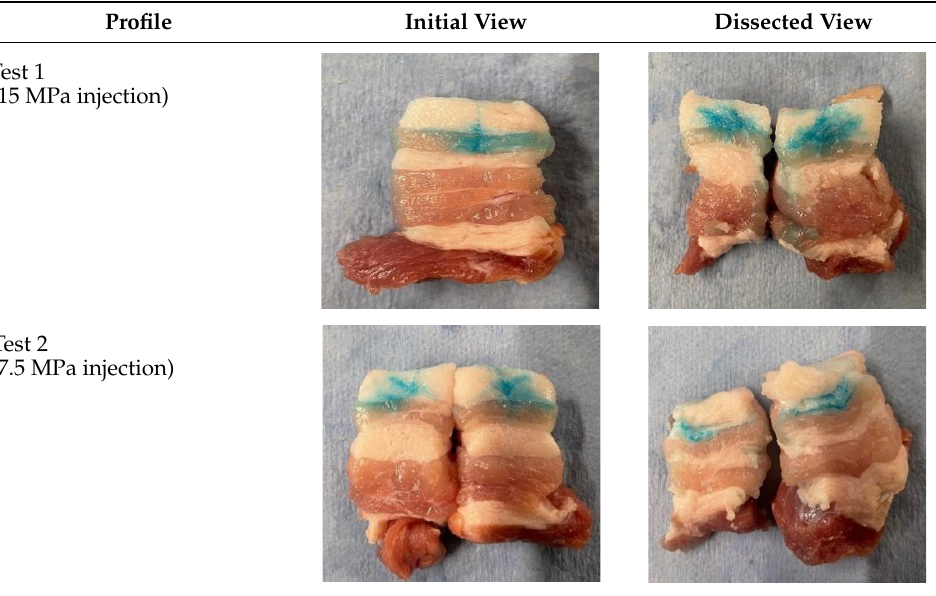
Table 6. Penetration Test (Porcine Tissue).